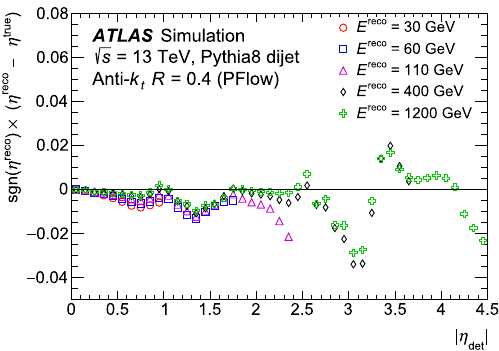
Fig. 6 The signed difference between the reconstructed and truth jet η , denoted by η reco and η true respectively. Each value is obtained from the corresponding parameterized function derived with the Pythia 8 MC sample and only jets satisfying p T > 20 GeV are shown